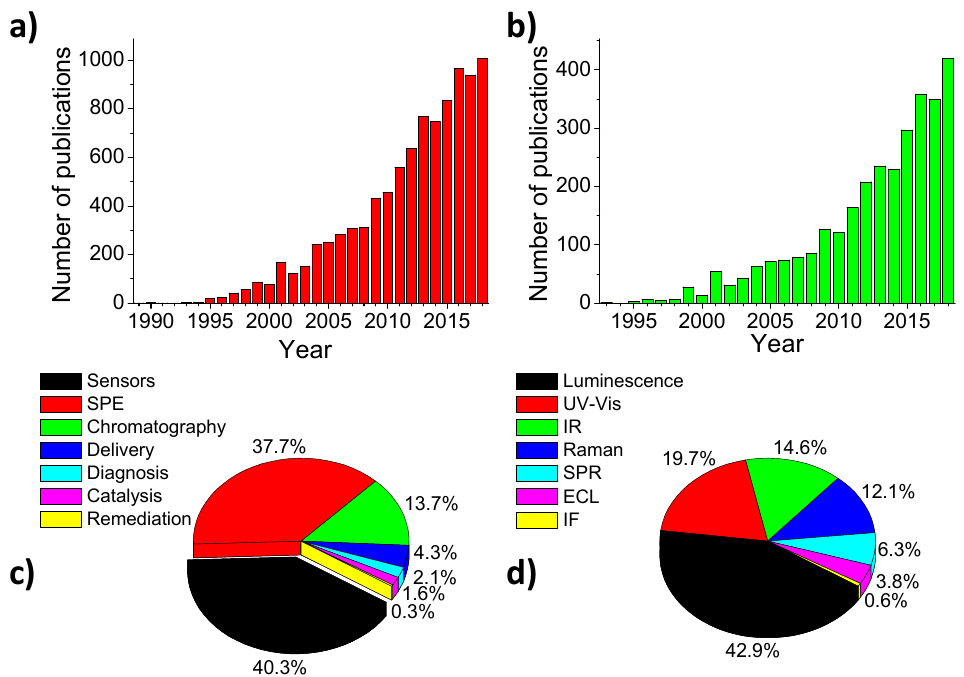
Figure 2. Number of publications of: ( a ) MIPs in the period 1989–2018; ( b ) MIPs used for sensor development in the period 1993–2018. ( c ) Distribution of MIP publications in different fields for the year 2018; ( d ) Optical transduction mechanisms used for the optical sensors published in 2018. SPE: solid-phase extraction; UV-Vis: ultraviolet-visible; IR: infrared; SPR: surface plasmon resonance; ECL: electrochemiluminescence; IF: interferometry. Source: Web of Science.